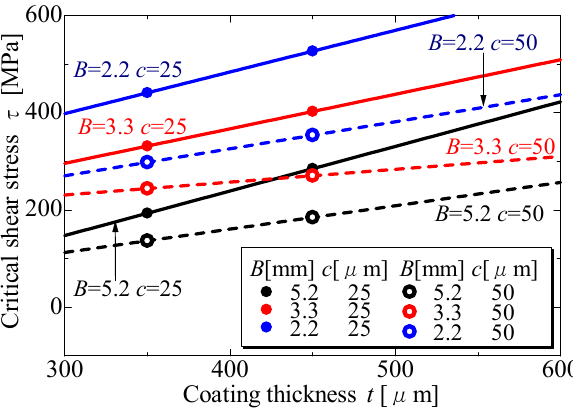
Figure 7. Influence of coating thickness on failure stress: Apparent failure stress increases with increasing coating